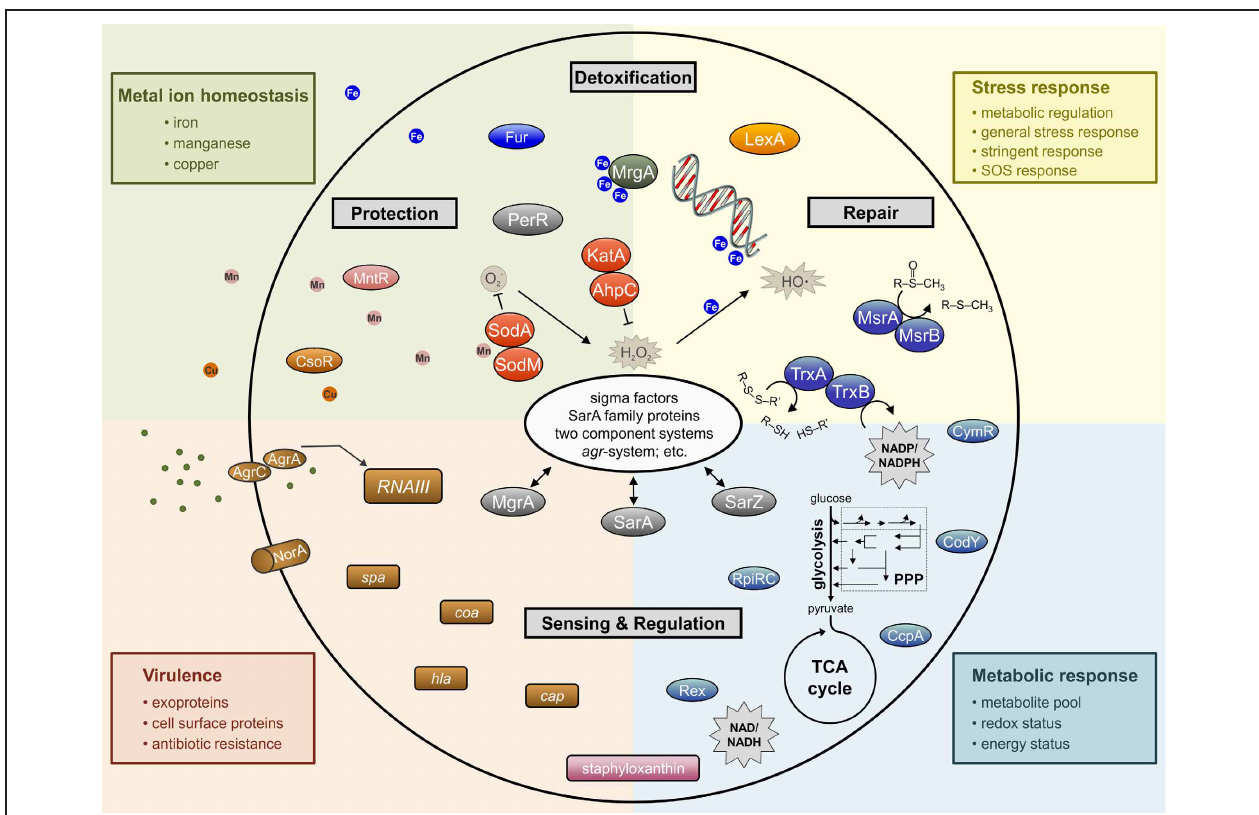
FIGURE 2 | Simplified schematic overview of important determinants involved in staphylococcal response to oxidative stress affecting whole cell physiology.